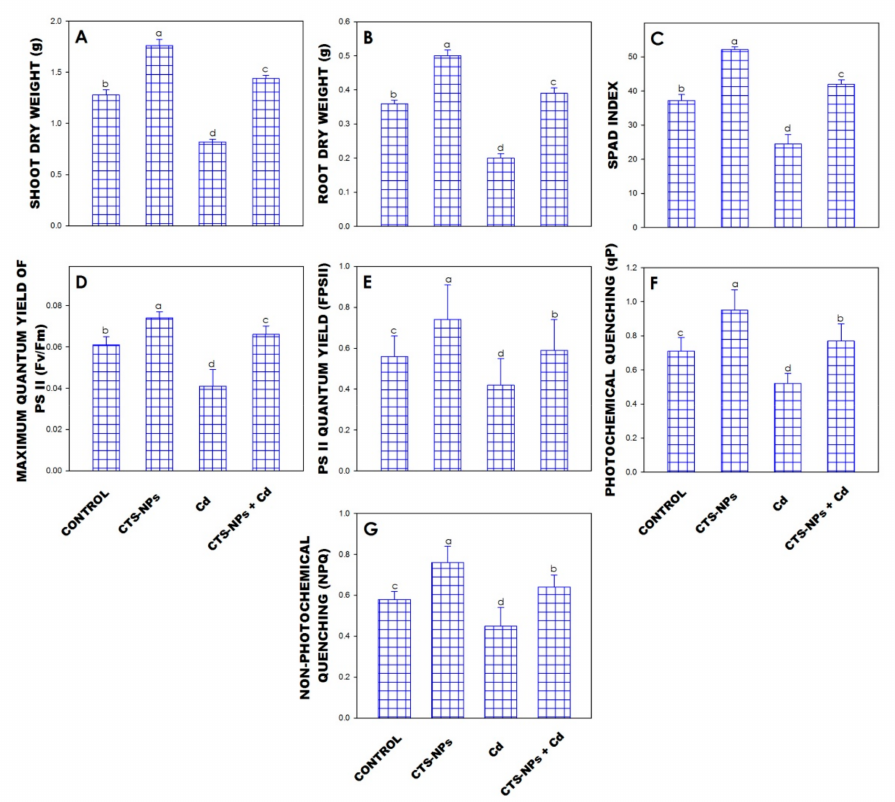
Figure 1. Effect of foliar application of chitosan nanoparticles (CTS-NPs) on shoot dry weight ( A ), root dry weight ( B ), SPAD index ( C ), maximum quantum yield of PSII ( D ), PSII quantum yield ( E ), photochemical quenching ( F ) and non-photochemical quenching ( G ) in cadmium (Cd) stress Solanum lycopersicum at 30 days after sowing. Values are the mean of five replicates with standard errors. Different bar letters show significant differences among treatments